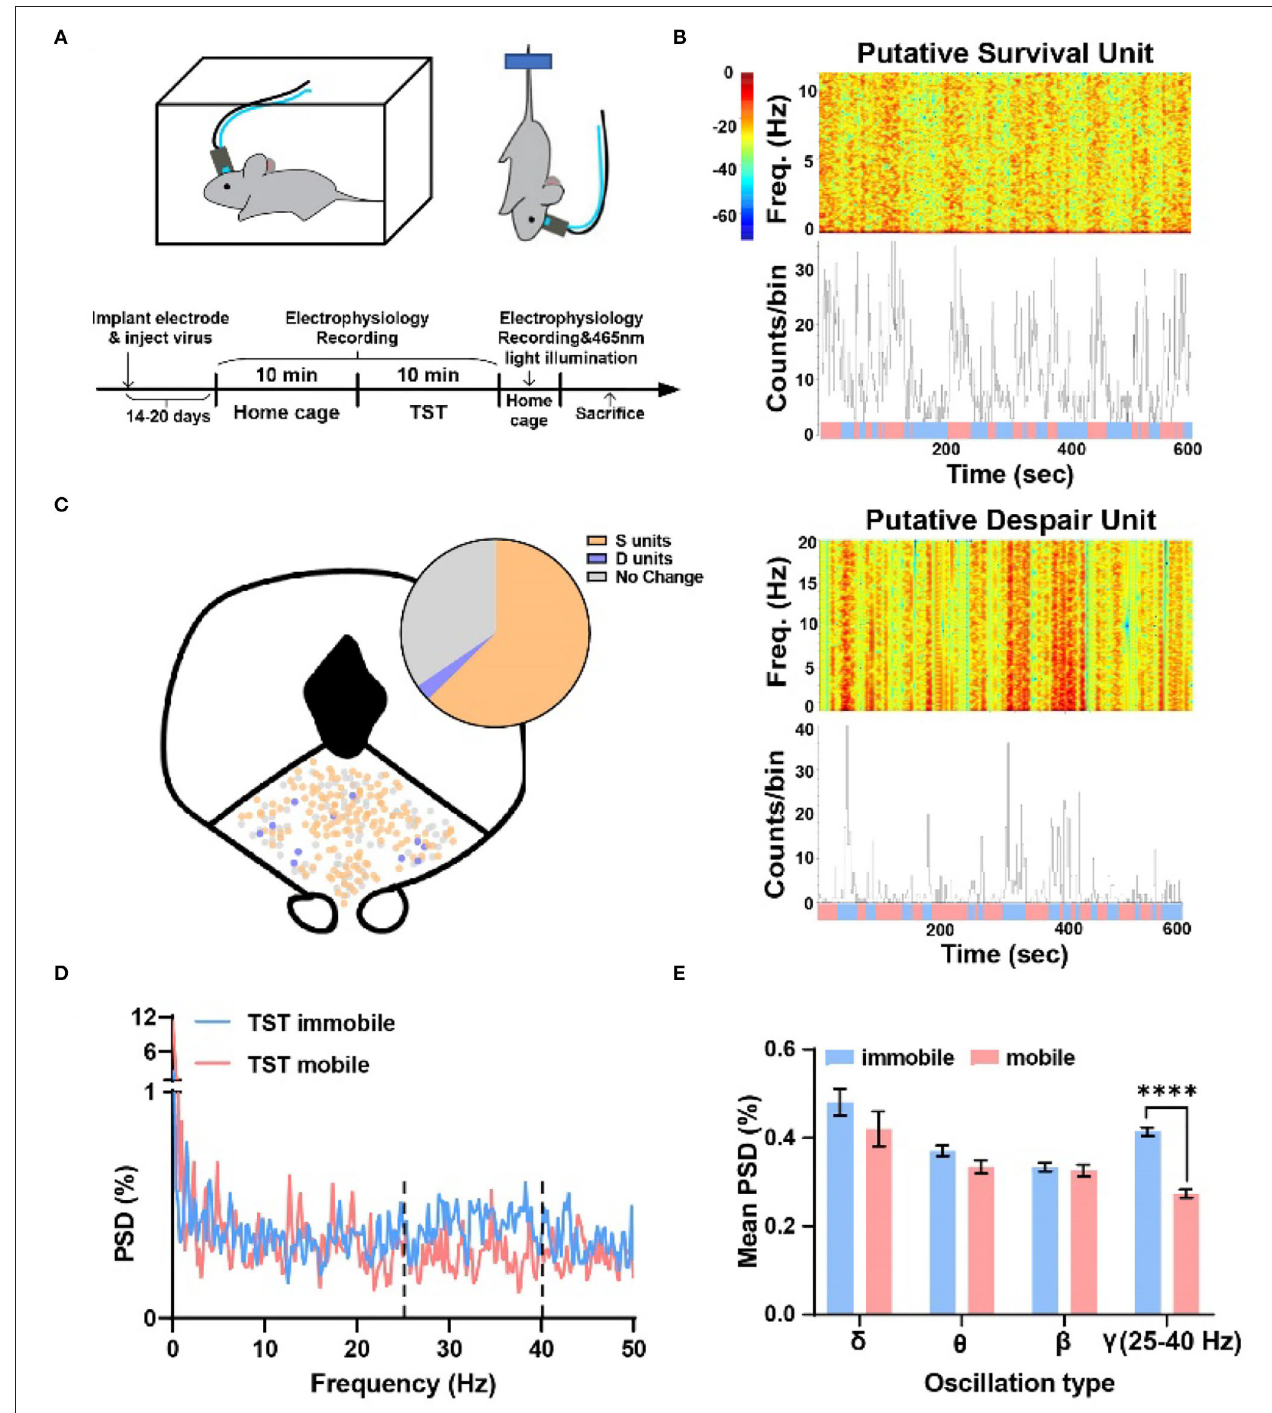
FIGURE 1 | Two types of units showing opposite changes during different states transition in TST, and the local field potential gamma oscillation of DRN anticipated despair-like behavior. (A) (Top) Behavioral test assembly. (Bottom) Experimental procedure. (B) (Top) Sample recording of a putative survival unit (S unit) during TST. Spectrogram and rate histogram showing drastic reduction in spike rate during the transition from TST mobile to immobile. (Bottom) Sample recording of a putative despair unit (D unit) during TST. Spectrogram and rate histogram showing a remarkable increase in spike rate during the transition from TST mobile to immobile (blue means immobile states, and red means mobile states). (C) The spatial location of different types of units in DRN during the transition from mobile to immobile in TST. N = 21 mice, total units = 248, S units = 150 ( ∼ 61%), D units = 11 ( ∼ 4%). (D,E) Sample of the power spectral densities (%) of TST mobile and immobile in DRN. The mean power spectral densities (%) during TST mobile and immobile states in different oscillation types. The mean PSD (%) of gamma oscillation (25–40Hz) showing a clear increase during immobile states (two-tailed paired t -test, **** p < 0.0001).